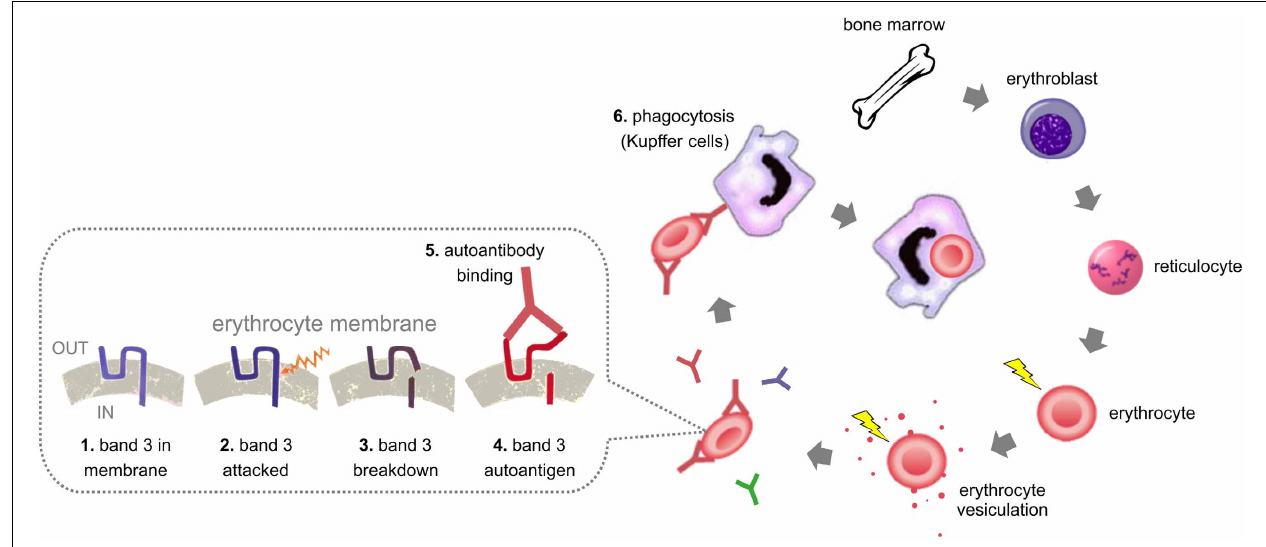
FIGURE 1 | The life and death of the erythrocyte. The numbers refer to the putative steps in the generation and recognition of removal signals.